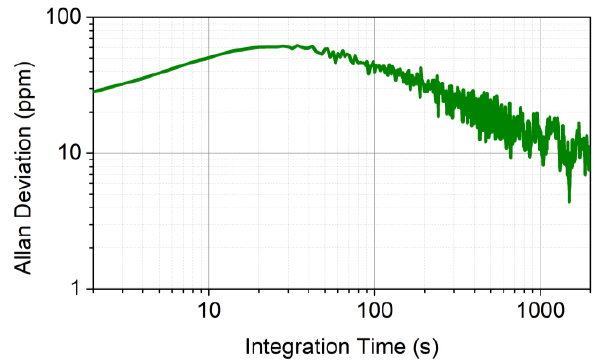
Figure 3. Allan deviation in ppm of the absolute humidity calculated using Equation (1).